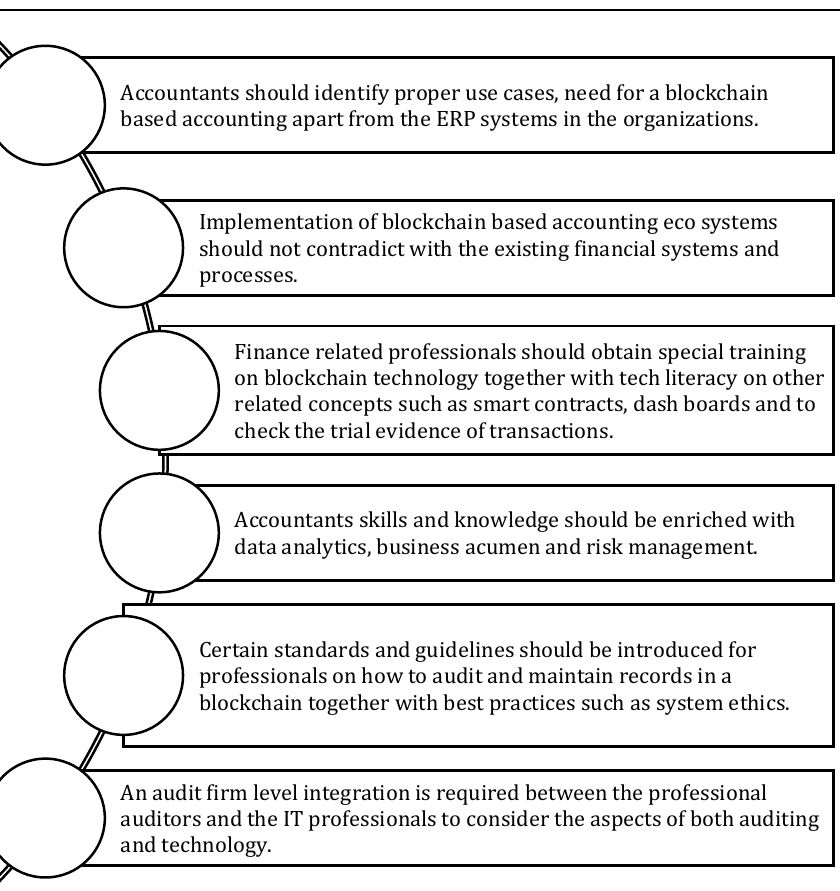
Figure 2: Summary of How the Accounting and Auditing Processes and Functions Should Adopt